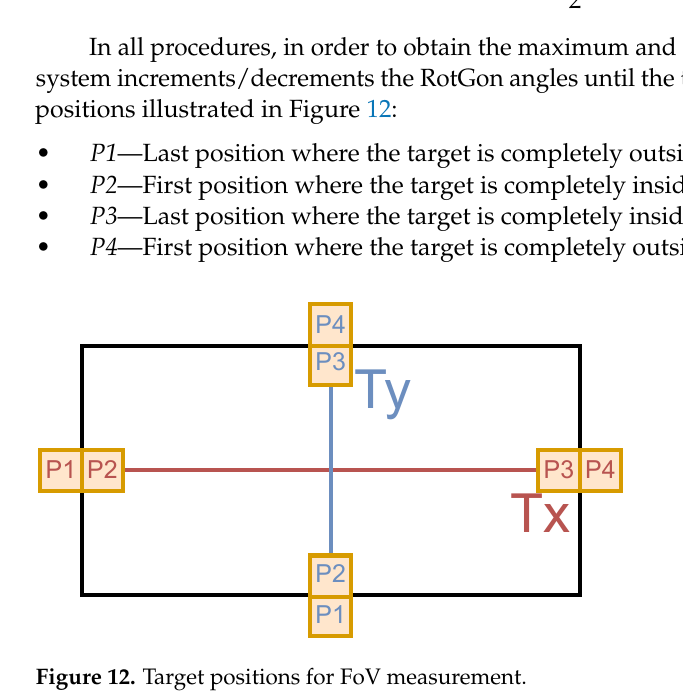
Figure 12. Target positions for FoV